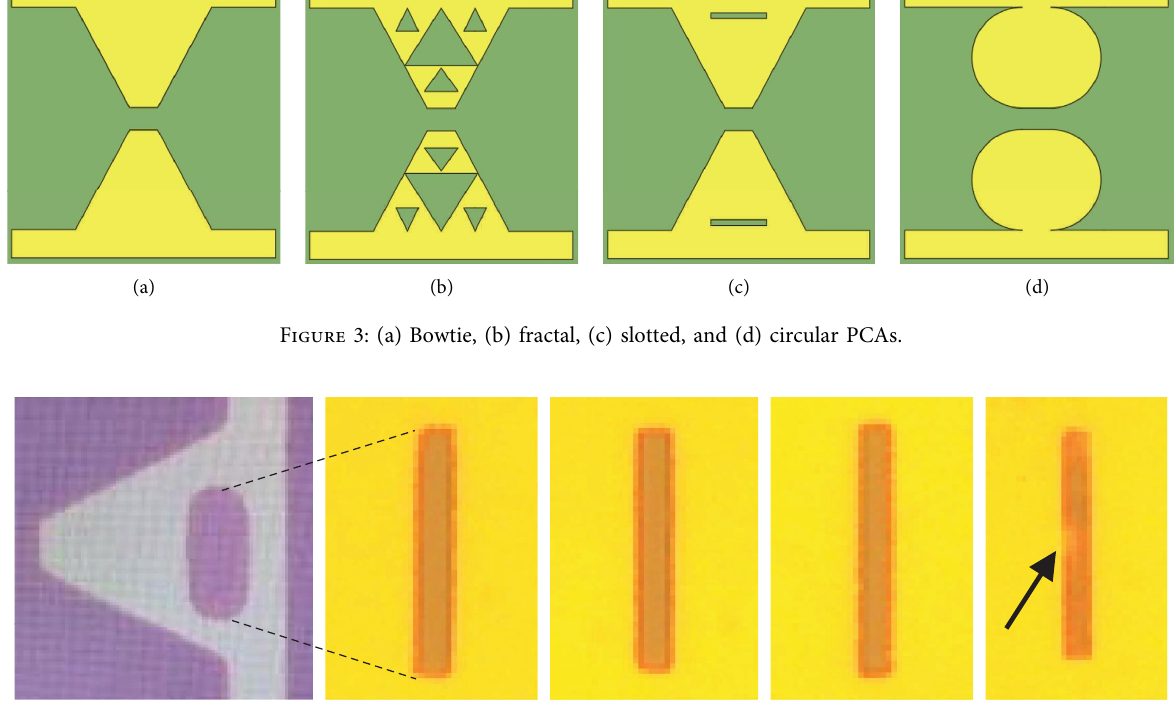
Figure 4: Slotted PCA (a) over etched slots. Slots etching time trials: (b) 5 seconds, (c) 3seconds, (d) 2 seconds, and (e) 1second. Tis etching test was conducted on silicon dioxide.